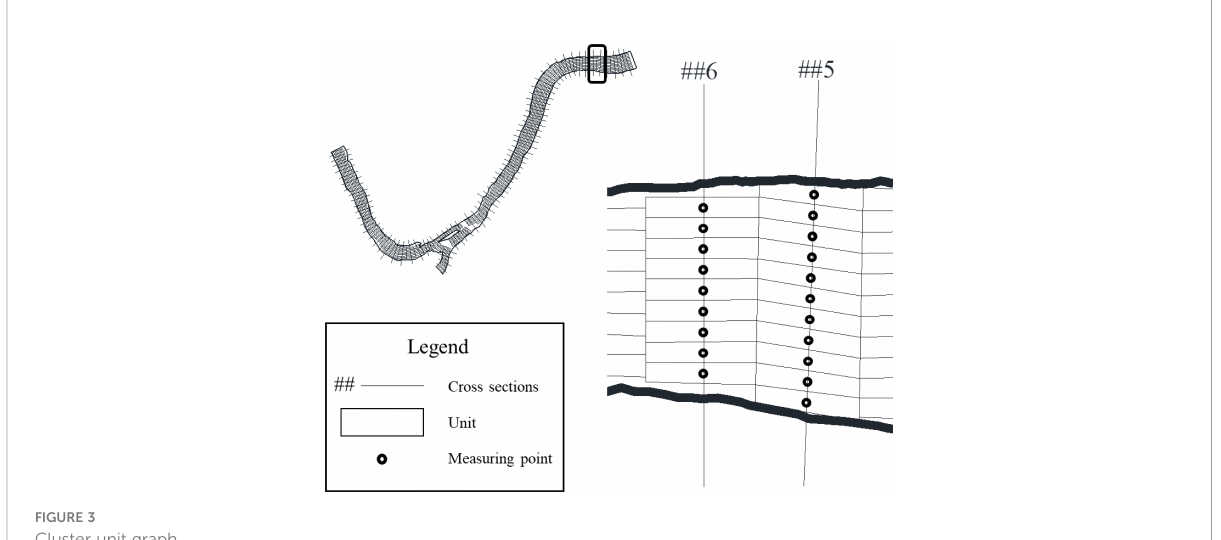
FIGURE 3 Cluster unit